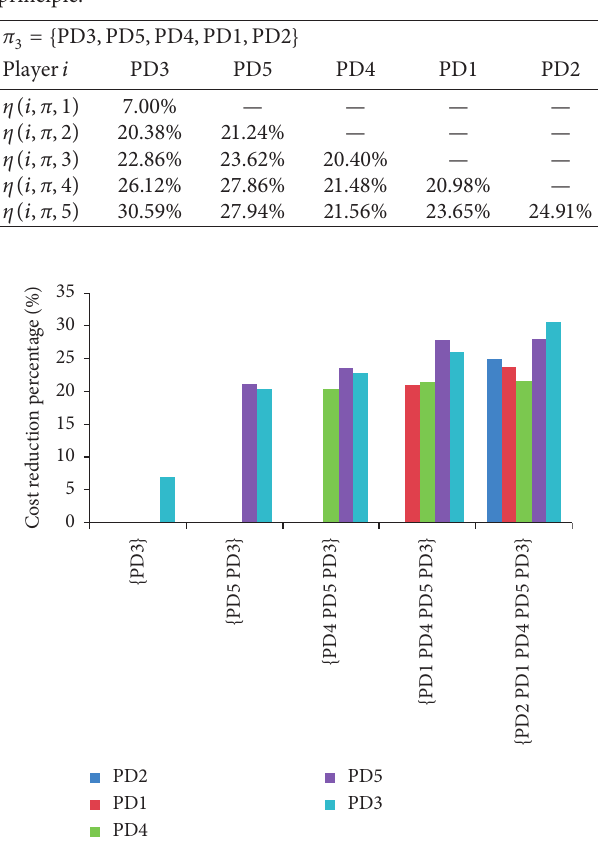
Figure 8: The variation of the cost reduction percentage of each petrol depot in the optimal